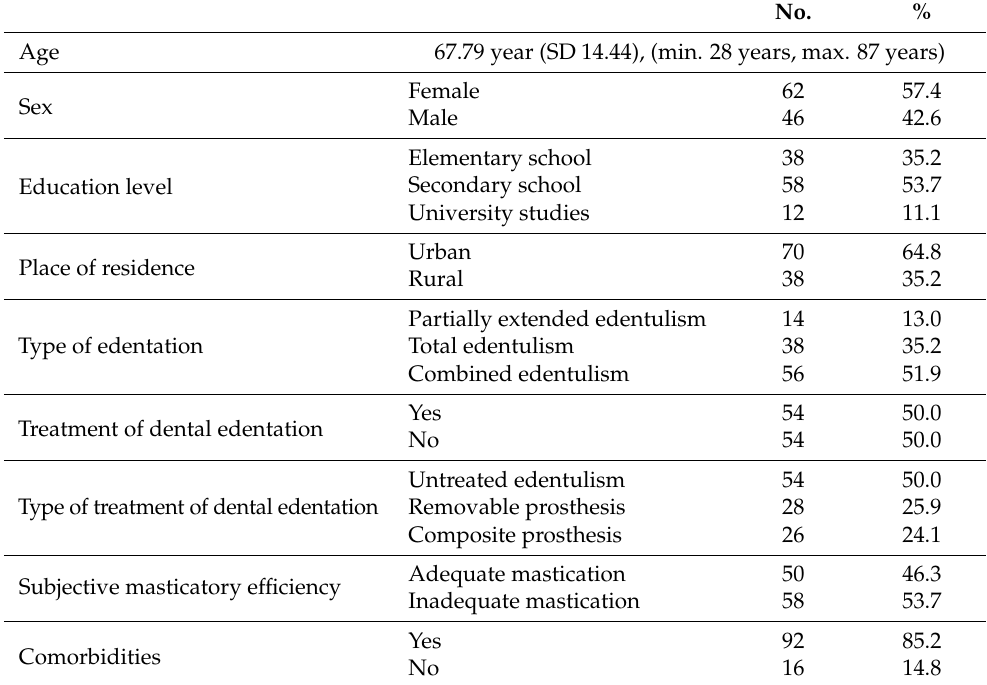
Table 1. Characteristics of the study